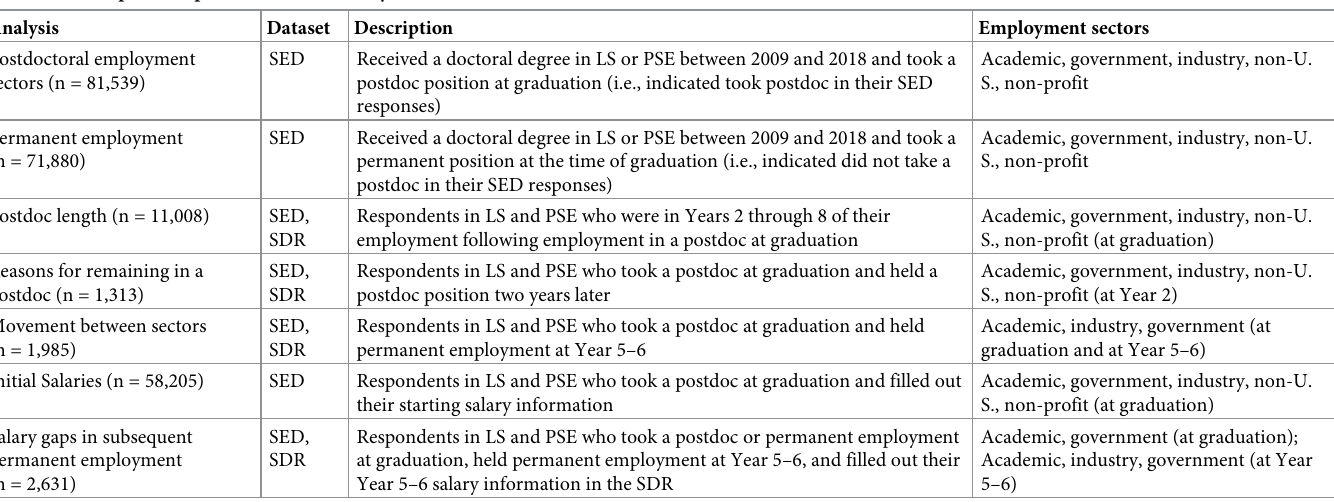
Table 1. Participant samples used for each